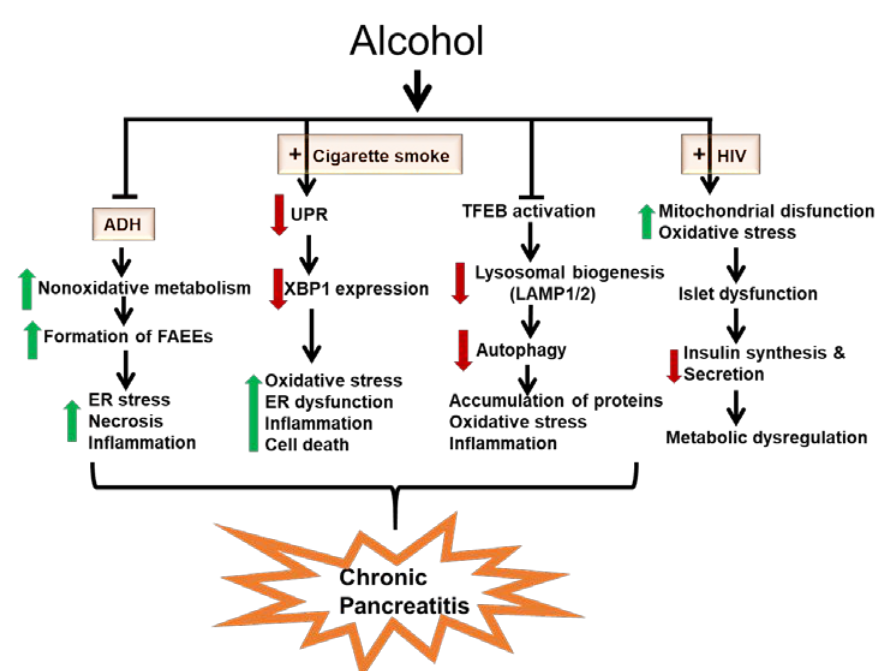
Figure 1. Schematic of ethanol-induced pancreatic dysfunction and pancreatitis development.